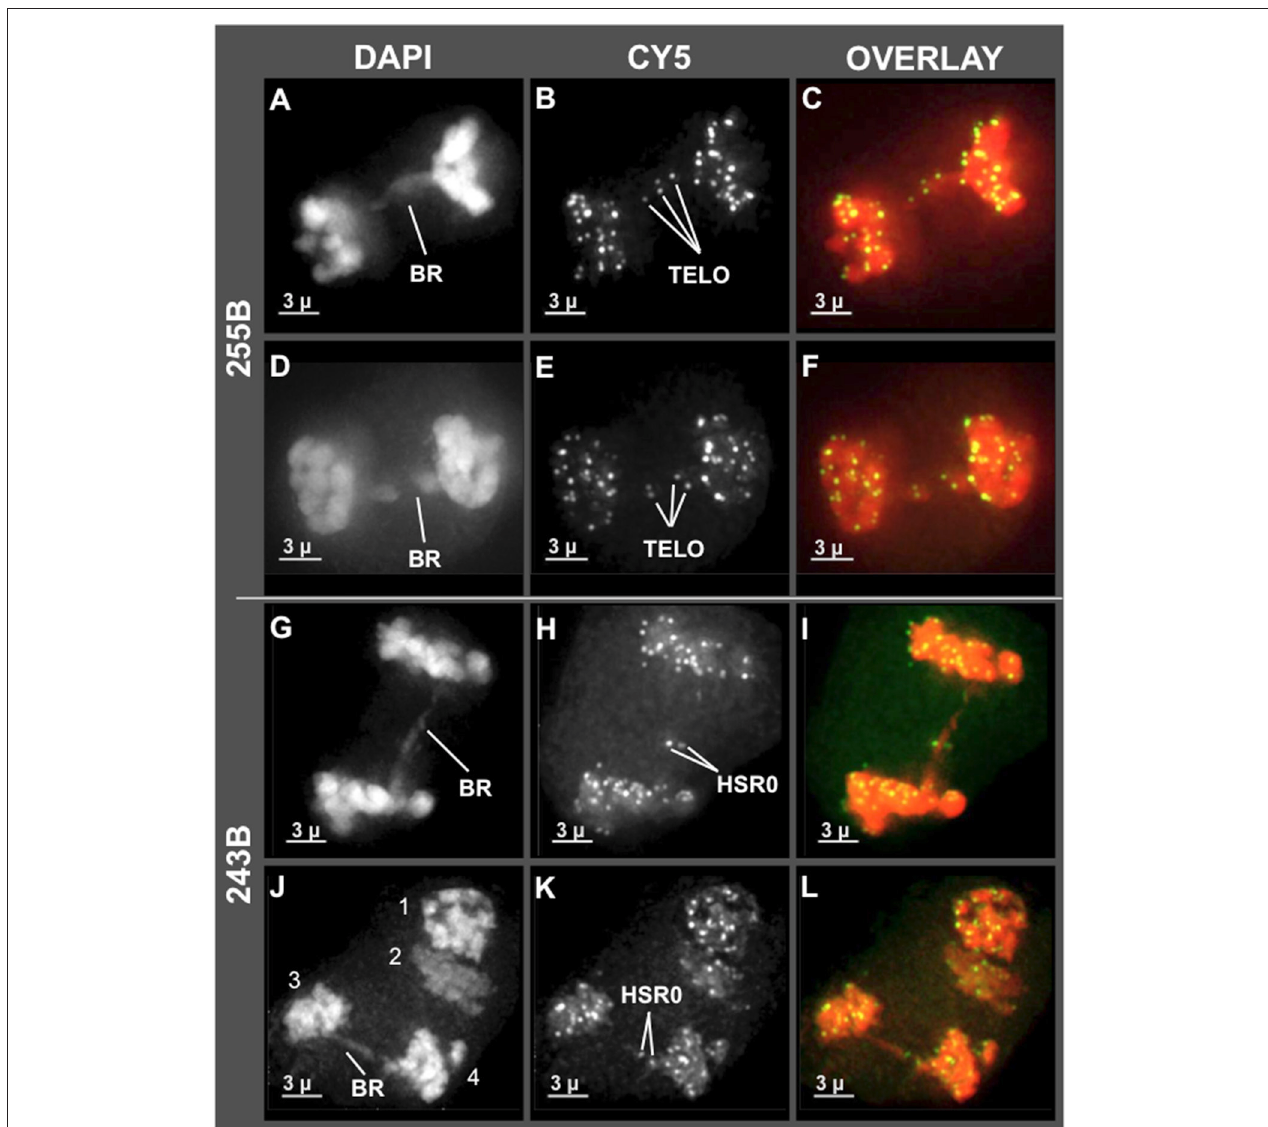
FIGURE 5 | Chromosome bridges with interstitial telomere and HSR0 signals at meiosis I and II. Projections of 3D FISH datasets were produced as described in Figure 1 . (A–F) Through-focus projections showing hop nuclei at anaphase I in plant 255B. The wavelength is indicated at top and the chromosome bridges (BR) and telomere FISH signals are (TELO) are indicated. (G–L) Through-focus projections of a hop nuclei at anaphase I (G–I) or anaphase II (J–L) from plant 243B. The chromosome bridges (BR) and HSR0 FISH signals (HSR0) are indicated. Telomere and HSR0 FISH signals can be observed on the bridges. The length of the scale bars (3 microns) is